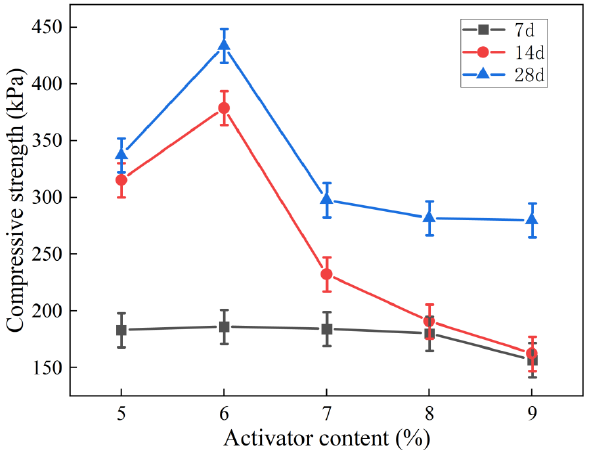
Figure 3. UCS of stabilized soils with different alkali activator contents.